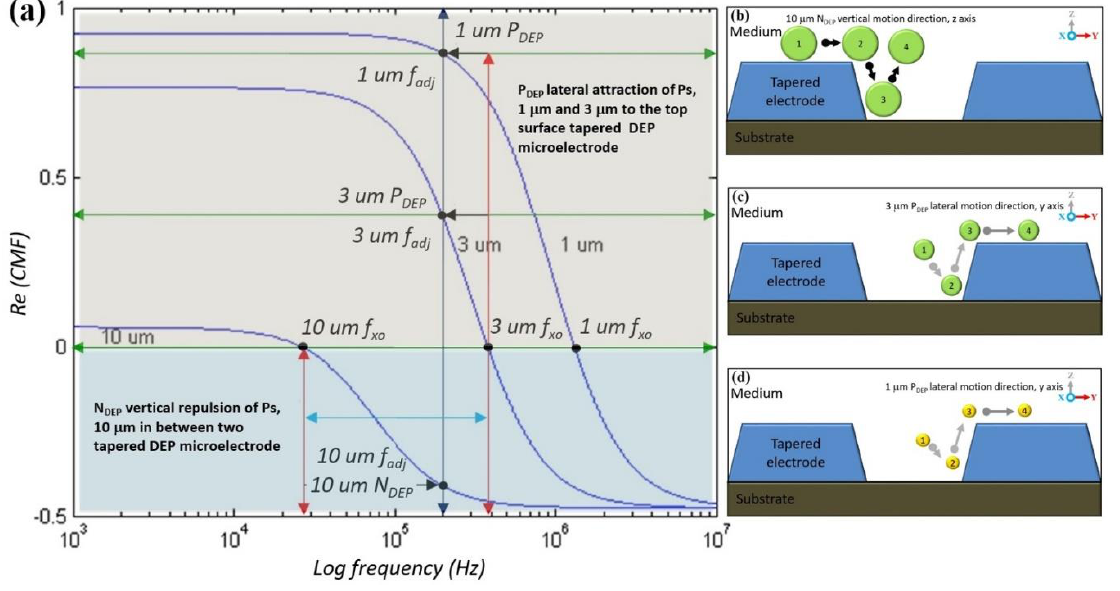
Figure 14. The CMF polarisation factor and positioning and stationing of 1  m, 3  m and 10  m